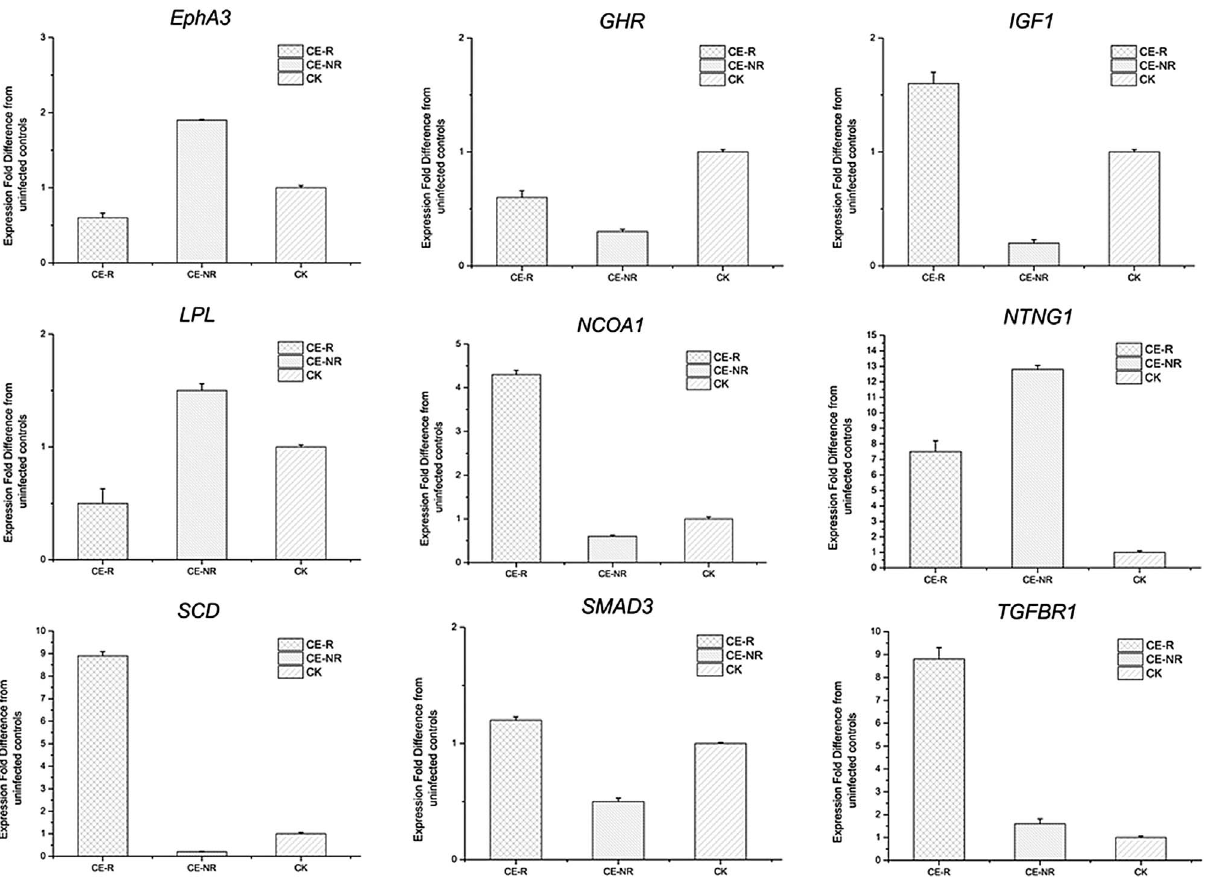
Figure 4. Validation of transcriptome data by qRT-PCR on nine randomly selected genes. Real-time PCR was employed to verify the regulation of genes detected by transcriptome. Nine differential expression genes were randomly selected. GAPDH was used as an internal